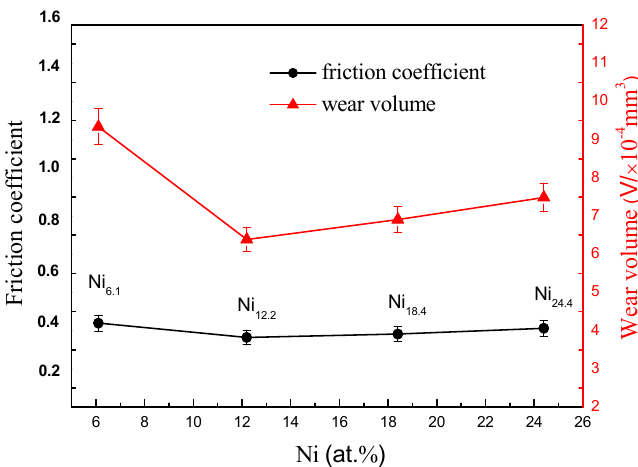
Figure 5. Curves of the friction coefficient and wear volume of the coatings with different Ni contents for 30 min.